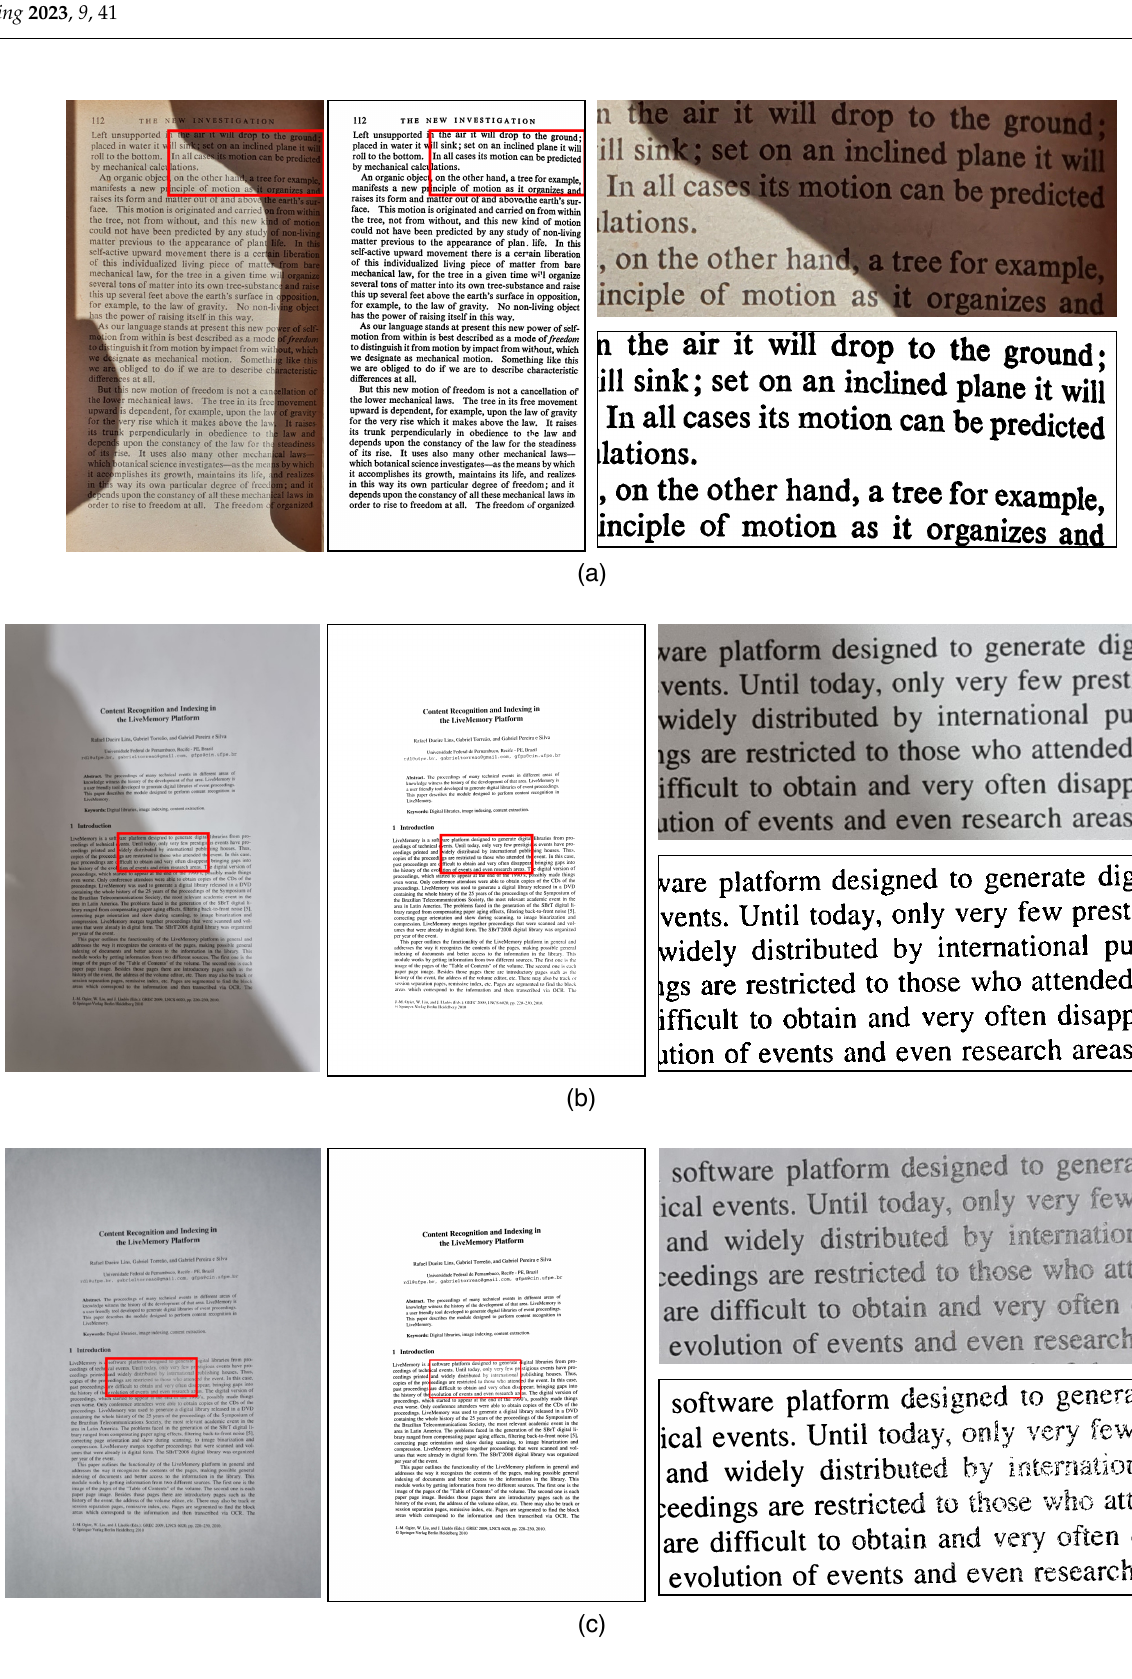
Figure 5. Dataset 1 example images. The red boxes indicates the crop region for the zoomed example next to each image. ( a ) Samsung Note 10+, book offset page, strong natural light, flash off with strong shadow, binarized by HuangUNet-B; ( b ) Samsung S21, laser printed, artificial light, medium shadow, flash off, binarized by Wolf-R; ( c ) Same as ( b ), but with flash on and binarized by